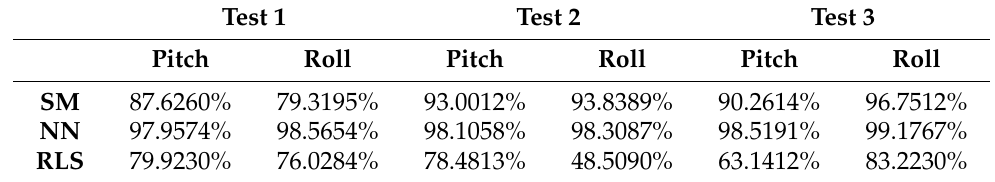
Figure 19. Test 3 results for roll. Table 4. Fitness on validation